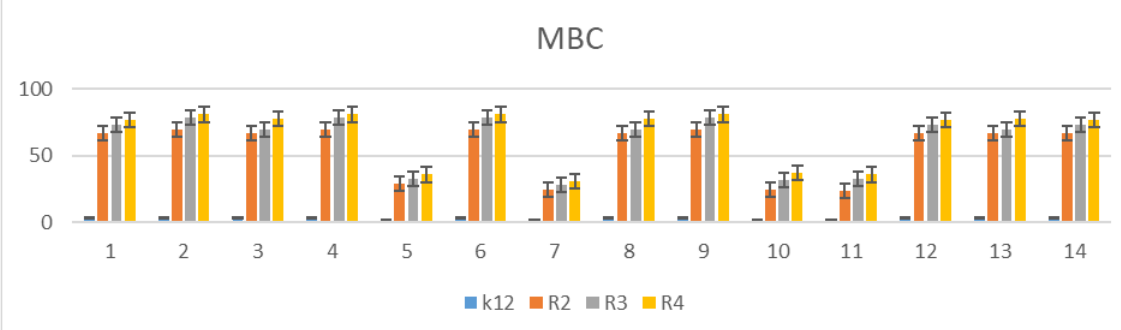
Figure 6. Minimum inhibitory concentration (MIC) of the p -quinols 1 - 10 and parent benzo- and hydroquinones 11 – 14 in model bacterial strains. The x -axis features compounds 1 – 14 used sequen- tially. The y -axis shows the MIC value in µg/mL − 1 .